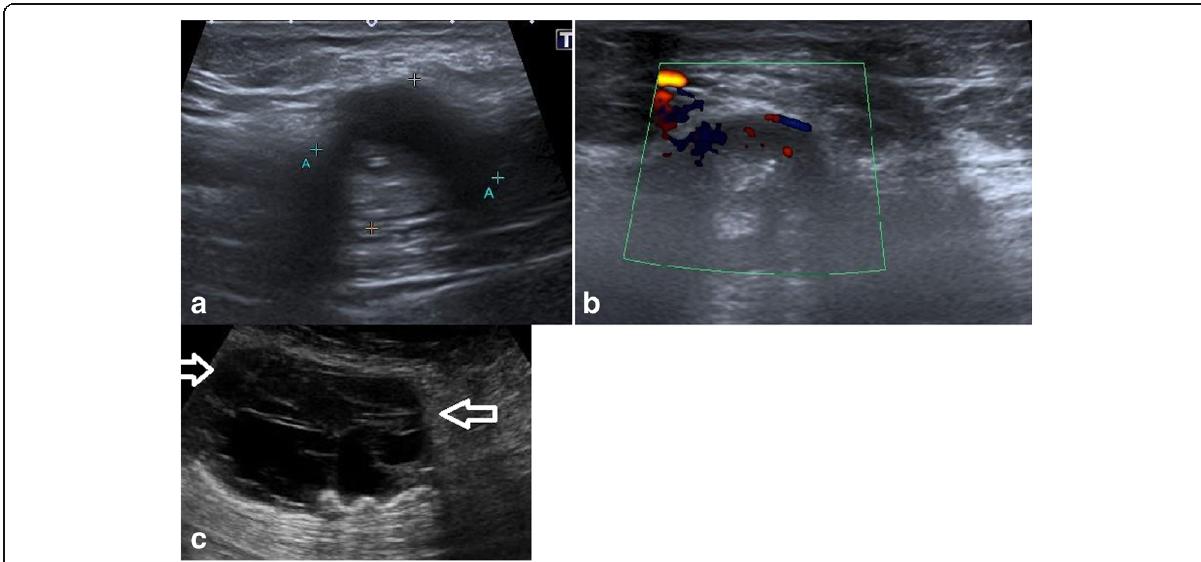
Fig. 5 a – c Ultrasound images for two different patients presenting with an anterior abdominal wall postoperative fluctuant swellings. a, b Ultrasound and color Doppler images for a patient with a right iliac fossa swelling showing hypoechoic subcutaneous collection with double echogenic suture fragments inside (curved white arrow in a) and peripheral vascularity (marginal vascularity) is seen in b; this was operatively confirmed as a suture abscess. c An ultrasound image for another patient showing a large septated supraumbilical abdominal wall subcutaneous collection (between the white open arrows) that was present after a mesh placement for an epigastric hernia repair; this was operatively proven